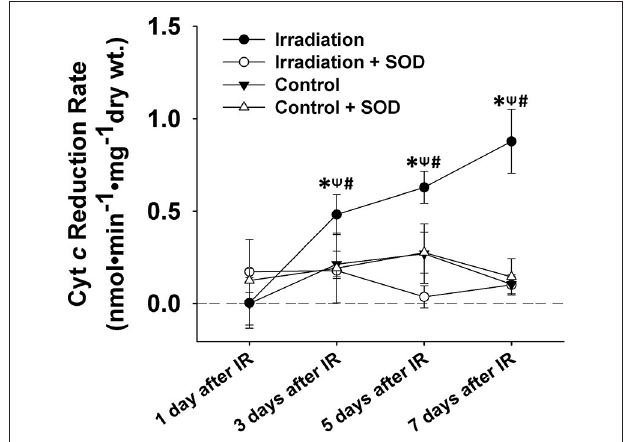
FIGURE 3 | Grouped data showing the cyt c reduction rate (nmol•min − 1 •mg − 1 dry wt) during the 5-min contractile period in the muscles of IR, IR + SOD, control, and control + SOD ( n ≥ 3 for all treatments). All data were calibrated by subtracting the control value of day 1. *Significant difference from control group at the same day; ψ Significant difference from SOD group within the same treatment at the same day; # Significant difference from 1 day after IR within the same treatment; Sig. (1-tail); p < 0.05.